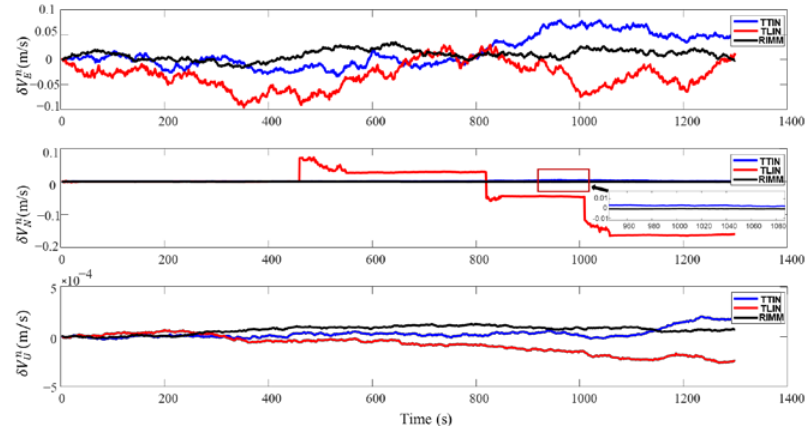
Figure 11. Velocity errors of three algorithms when DVL works in a complex environment. Table 5. Velocity error parameters for the three algorithms when DVL w orks in a c omplex e nvi- ronment.